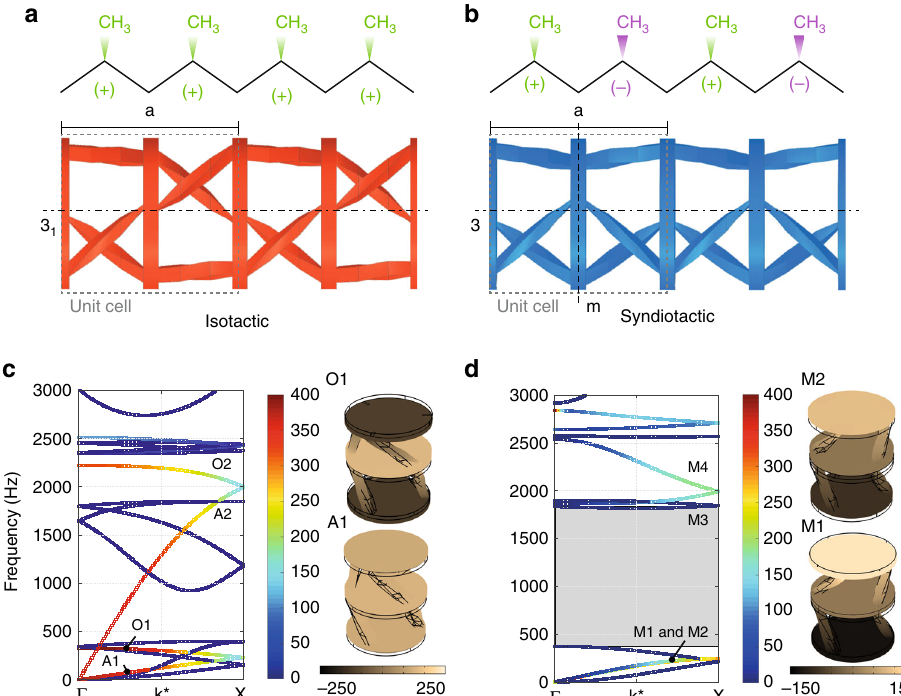
Fig. 4 In fl uence of the tacticity. a, b Schematic representation of the concept of tacticity introduced as the relative stereochemistry of chiral elements in the case of the polypropylene (top panels) inspiring the design of two periodic diadic arrays of TROs in isotactic and syndiotactic con fi guration (bottom panels). The two structures differ for the tacticity of the non-centrosymmetric elements. c, d Band diagrams for the isotactic and syndiotactic con fi guration. The dispersion curves are color-coded based on a polarization coef fi cient that quanti fi es the rigid motion (rotation + translation) about the z -axis of the fi nite size atoms. A large bandgap between 374 Hz and 1816 Hz in the syndiotactic arrangement is visible and highlighted as a light gray rectangle. Higher frequency modes A2, O2, M3, M4 are reported in Supplementary Note 5 and shown in Supplementary Fig.